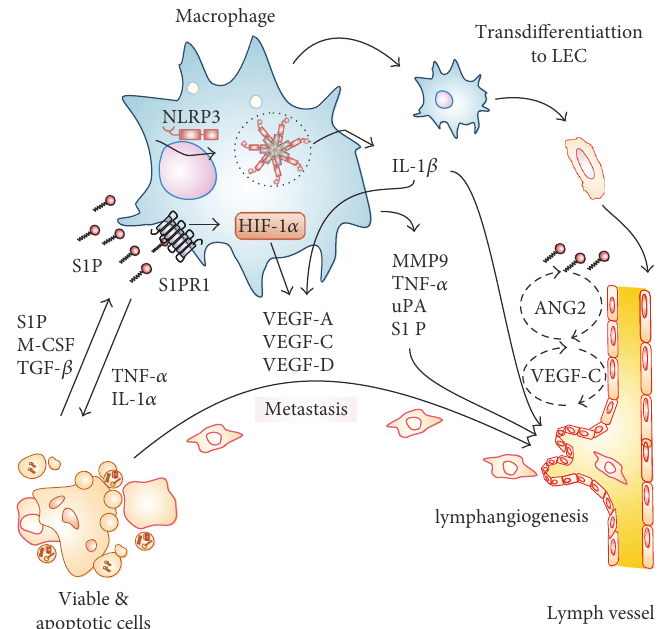
Figure 1: S1P-activated macrophages in lymphangiogenesis. Apoptotic cell-derived factors such as S1P, M-CSF, and TGF- β in fl uence the macrophage phenotype. Triggering S1PR1 on macrophages causes NLRP3 in fl ammasome activation with the subsequent maturation of IL-1 β . Released IL-1 β provokes lymphangiogenesis in autocrine and paracrine manner by inducing VEGF-C in macrophages and endothelial cells. In macrophages, hypoxia-induced transcription factor HIF-1 controls the expression of VEGFs. Macrophages produce various factors such as MMP9, TNF- α , uPA, and IL-1 α . These, together with VEGFs, induce lymphangiogenesis directly or by inducing VEGFs production by endothelial cells in multiple steps (discontinuous line). S1P also induces secretion of ANG2 from LECs (by unknown mechanisms, discontinuous line), to trigger lymphangiogenesis. In addition, macrophages may transdi ff erentiate to LECs. For details, see the